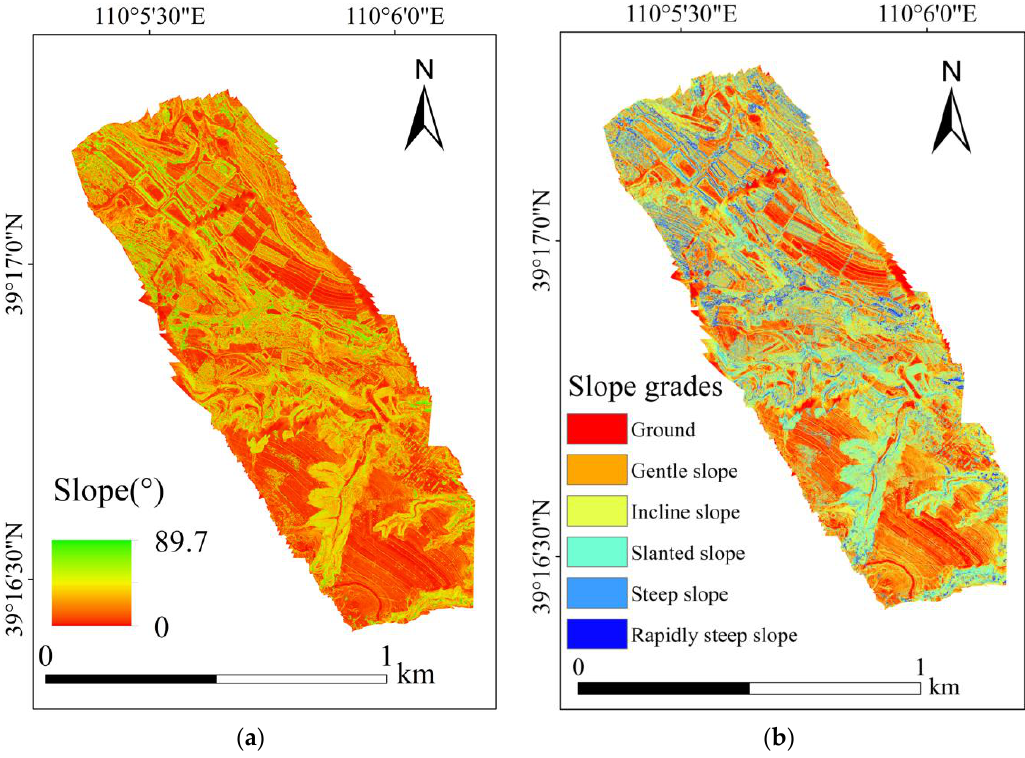
Figure 10. Slope and grades of the study area: ( a ) slope; ( b ) slope grades.